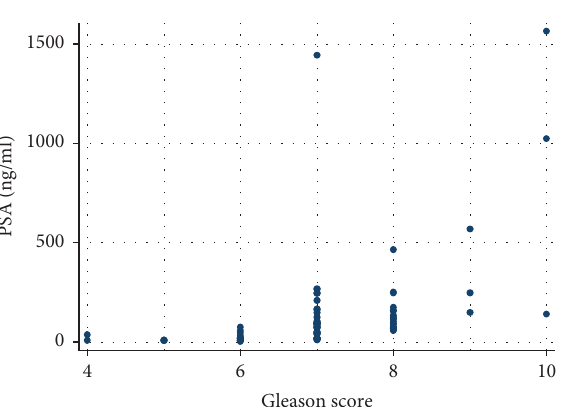
Figure 1: Correlation of PSA level at diagnosis as a function of the Gleason